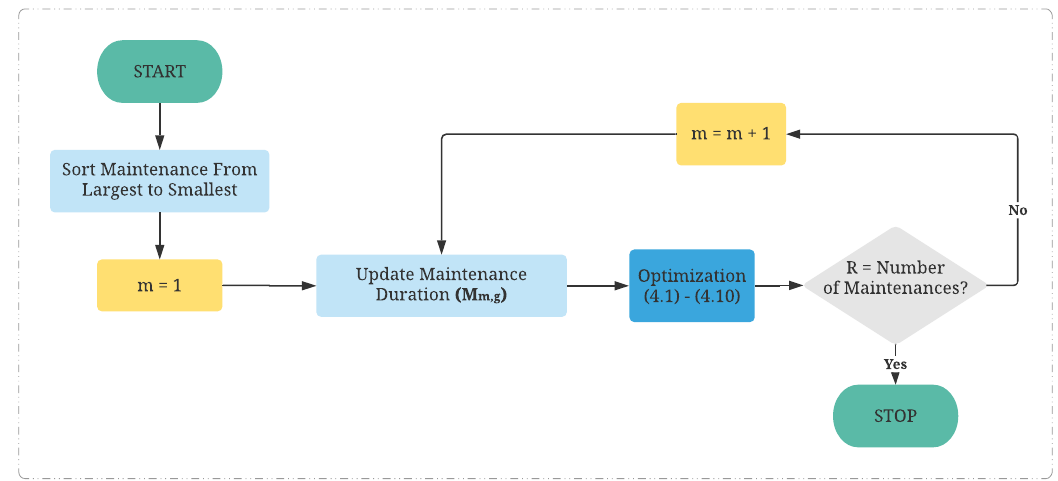
Figure 2. Maintenance Optimization